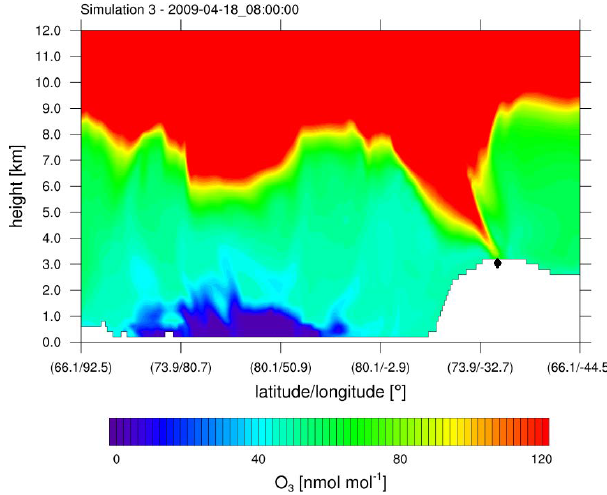
Figure 6. Ozone mixing ratio obtained from simulation 3 ( β = 1 . 5) against height along a horizontal line through Summit; see Fig.